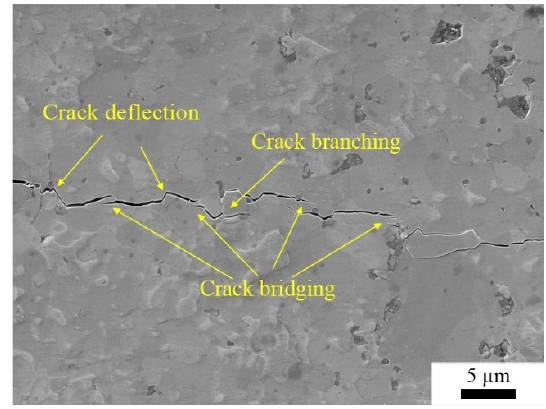
Figure 9. The crack propagation of sample ZT10.